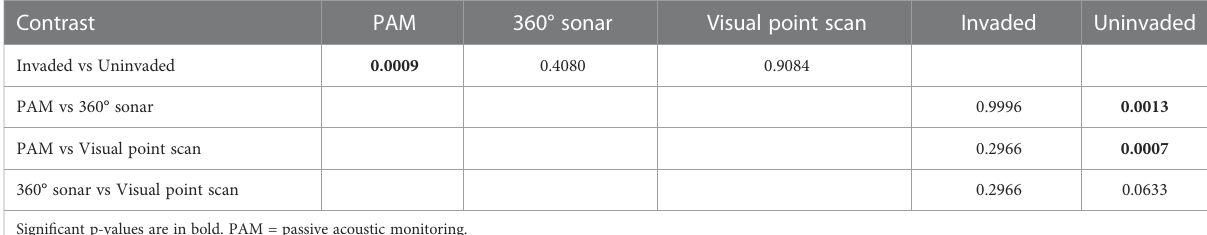
TABLE 4 P-values obtained after post-hoc inspection of the interaction between the survey methods and Giant Salvinia invasion (signi fi cant in the model) using the “ emmeans ” package in R.